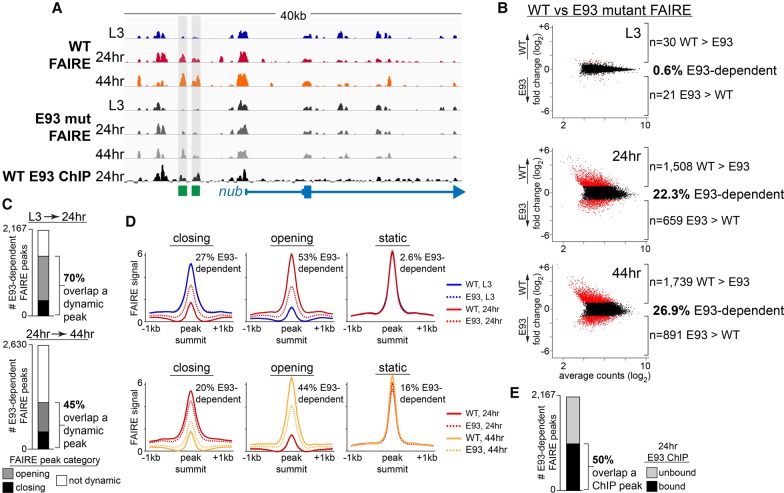
E93 binding is required for temporally dynamic open chromatin changes. (A) Browser shot showing FAIRE-seq signal from wild-type and E93 mutant wings. E93 ChIP-seq signal from wild-type 24-h wings is shown in black. The nubvein and nubmargin enhancers are shown in green. (B) MA plots of FAIRE-seq signal in the top 7699 FAIRE peaks from each wild-type and E93 mutant wing data set. Differentially accessible peaks are colored red. (C) Stacked bar plots of the fraction of E93-dependent FAIRE peaks that overlap a temporally dynamic FAIRE peak. (D) Line plots of the average FAIRE-seq signal in FAIRE peaks that close, open, or remain unchanged between consecutive time points. The percentage of FAIRE peaks in each category that are E93-dependent is shown. Solid lines show wild-type FAIRE-seq signal. Dashed lines show E93 mutant FAIRE-seq signal. (E) Stacked bar plot showing the fraction of E93-dependent FAIRE peaks that overlap an E93 ChIP peak.